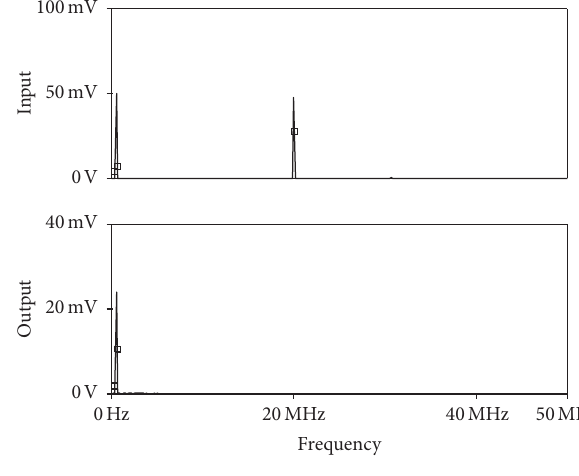
Figure 11: Frequency spectrum of input and output signals.